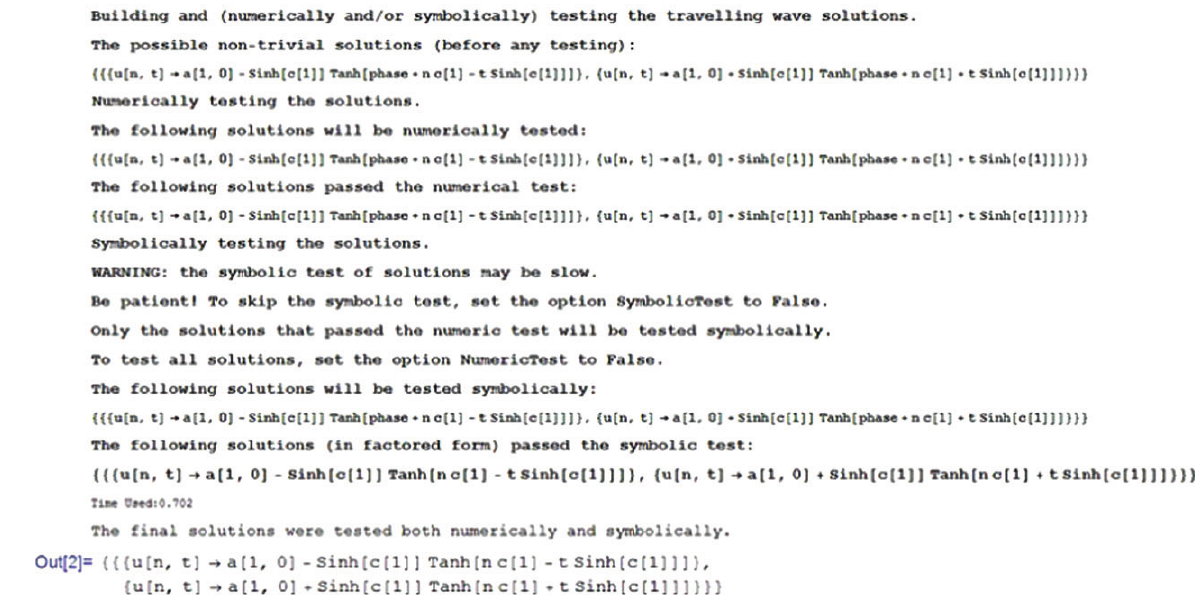
Figure 14 Single Toda lattice DDE equation by using Mathematica ® : wave solution in